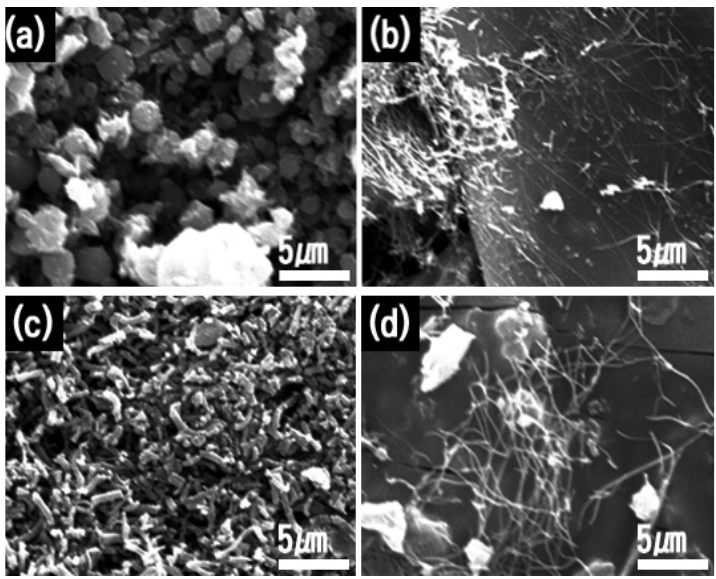
Figure 2. FESEM images of calcined samples; ( a ) S1(550), ( b ) S2(550), ( c ) S4(550) and ( d ) S5(550).